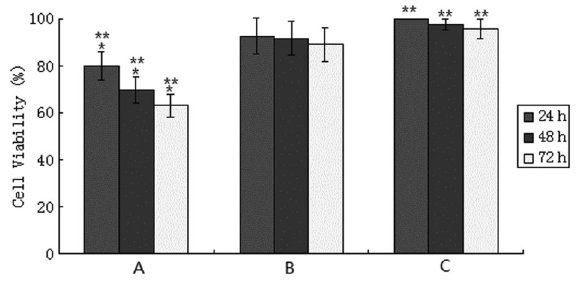
Figure 2. Viability of HPDL fibroblasts treated with AGE-BSA, BSA and control for 24, 48, and 72 h. Pooled analysis indicated significant differences in viability at 24, 48, and 72 h in group A (*P , 0.05), and significant differences between group A and group C (**P , 0.01), but no significant difference in the viability of group B and group C at any time (P . 0.05). One-way ANOVA was used for statistical